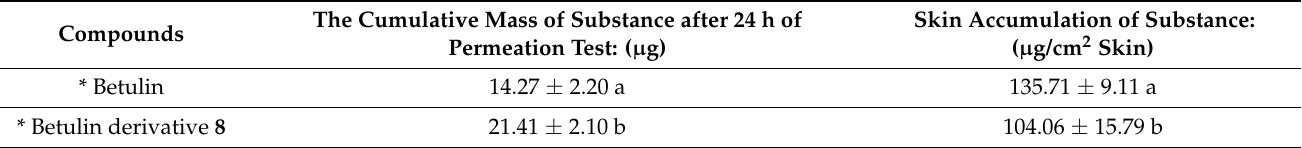
Table 3. Permeation of active substances through skin and the amounts of extracted active ingredients accumulated in it. The Cumulative Mass of Substance after 24 h of Compounds Permeation Test: ( µ